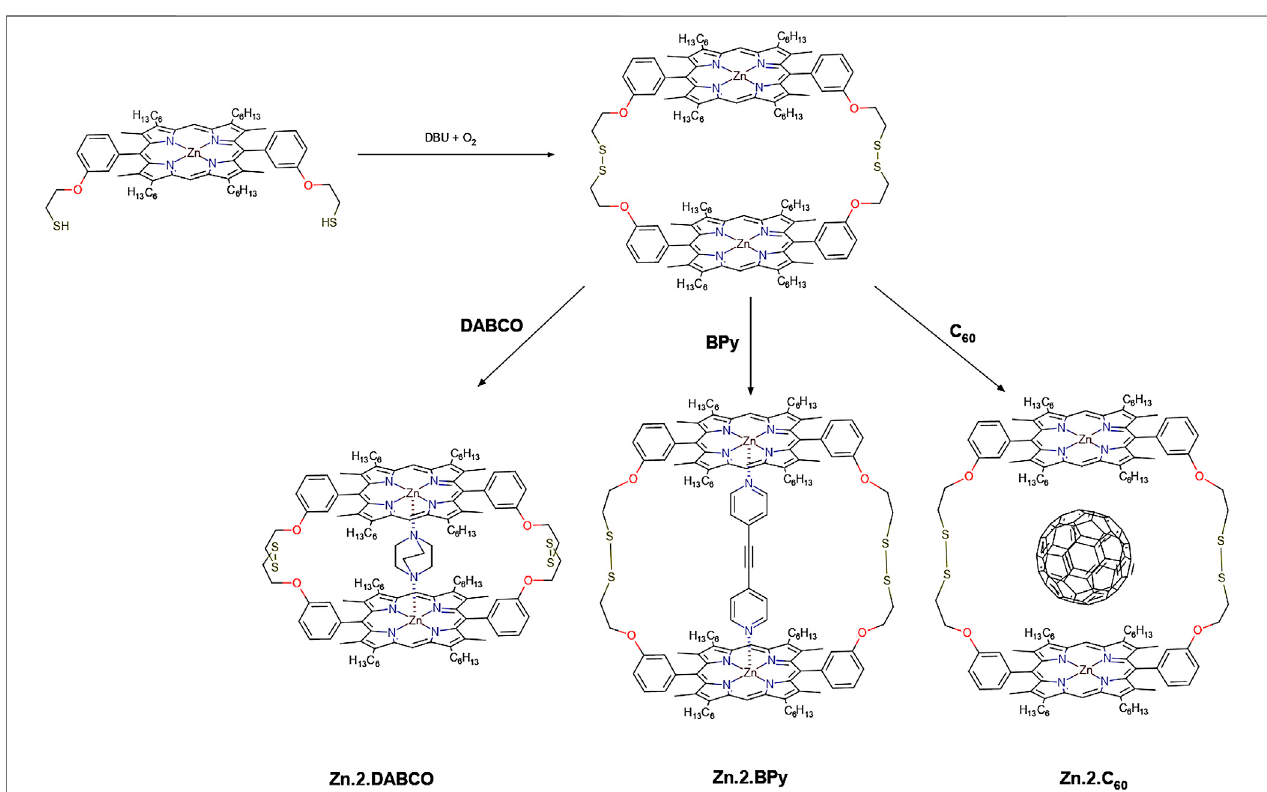
FIGURE 14 | Binding of guests inside the adjustable porphyrin dimer receptors (Kieran et al., 2005).